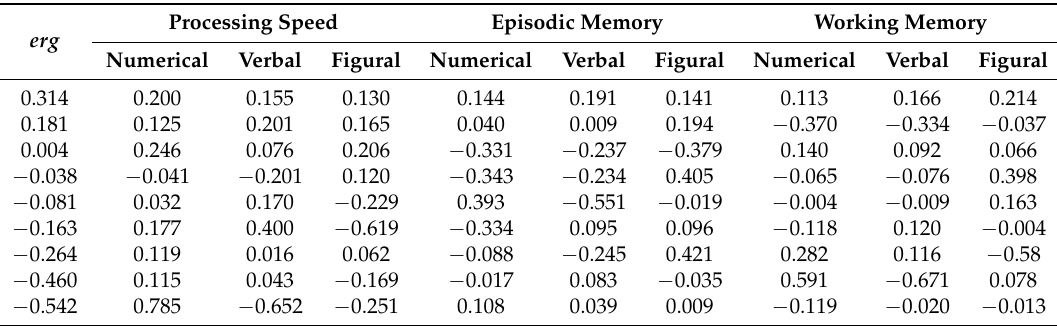
Figure 4. Scree plot for three artificial situations of ergodicity, fully ergodic (independently sampled covariance matrices), fully non-ergodic (identical covariance matrices), and an intermediate case with a 50% mixture, together with the ergodicity values of the nine cognitive tasks from the COGITO study (raw and de-trended). Table 3. The ergodicity values and the corresponding nine factors of the ergodic subspace analysis (ESA) on the de-trended cognitive data from the COGITO